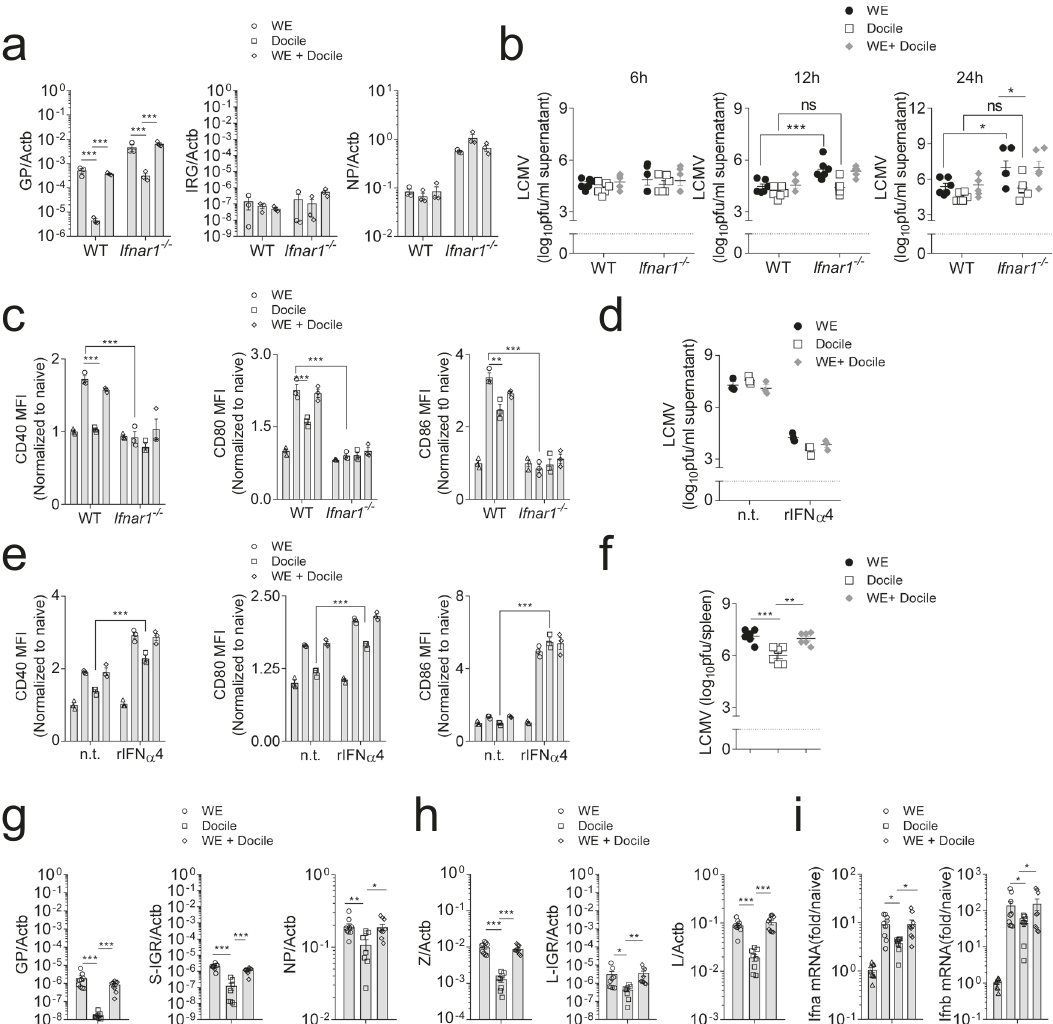
Fig. 6 Fast replication of the LCMV-WE strain induced enhanced IFN-I production and promoted DC maturation. a – c C57BL/6 or IFNAR1 de fi cient GM- CSF induced BMDCs were infected with LCMV-WE or LCMV-Docile at MOI 1. a GP, IGR, and NP region RNA levels were assessed using RT-PCR from infected BMDCs ( n = 3). b Virus titers were determined in the supernatant of LCMV infected BMDC ’ s at 6, 12, and 24 h post-infection ( n = 6). c Co- stimulatory molecule expression on LCMV infected BMDCs was monitored by fl ow cytometry 24 h post-infection. d , e GM-CSF induced BMDCs were infected with LCMV-WE, LCMV-Docile, or co-infected at an MOI 1 in the presence or absence of 100U/ml recombinant IFN α 4 ( n = 3). d Virus titers were determined in cell supernatant 24 h post-infection ( n = 3). e Co-stimulatory molecule expression on LCMV infected BMDCs was monitored by fl ow cytometry 12 h post-infection ( n = 3). f – i C57BL/6 mice were infected with LCMV-WE, LCMV-Docile, or both for 2 days. f Virus titers were determined in spleen tissues of infected animals ( n = 6). g GP, S-IGR, and NP h Z, L-IGR, and L RNA was determined in spleen tissue ( n = 6). i pan-IFN- α and IFN- β mRNA transcripts were measured from spleen tissue ( n = 6). (Error bars show SEM, * p < 0.05, ** p < 0.01, *** p < 0.001, and ns indicates statistically not signi fi cant between the indicated